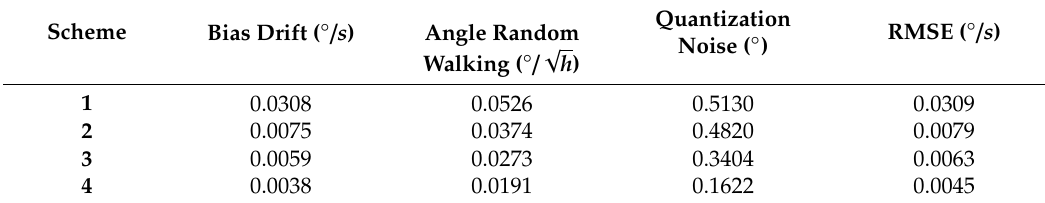
Table 1. Bias drift, angle random walking, quantization noise, and root mean square error (RMSE) for the di ff erent schemes.